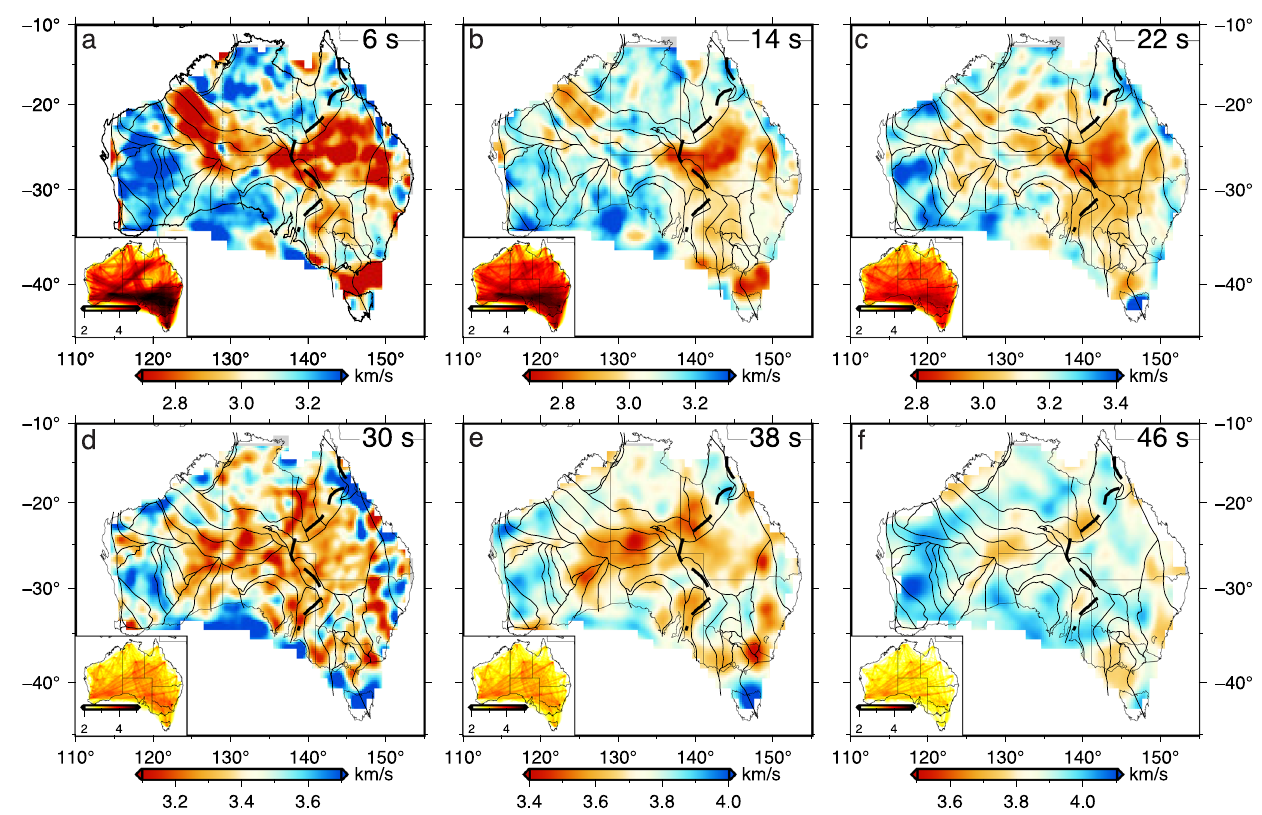
Fig. 3 | Surface wave group velocities. Group velocity maps at periods of a 6s, b 14s, c 22s, d 30s, e 38s,and f 46s.TheArcheancratonicregionsarelabeledin a . The black lines indicate the major tectonic boundaries 48 . The inset shows the ray-